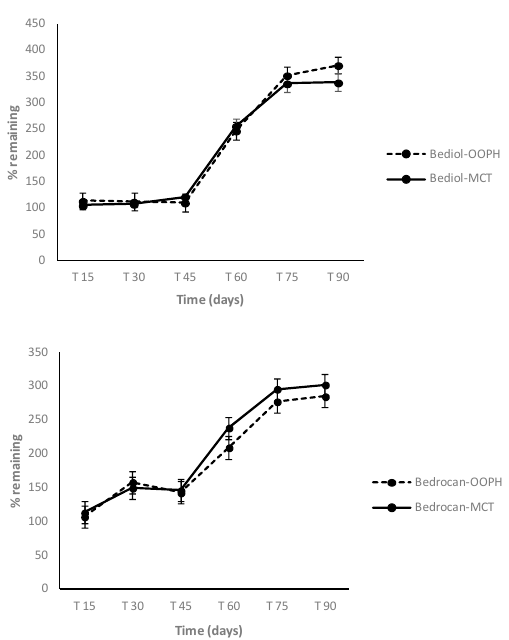
Figure 3. CBN (cannabinol) trends in Bediol ® and Bedrocan ® -based oils as a function of storage time and lipid sources: PhEur-grade olive oil (OOPH) and medium-chain triglycerides (MCTs).